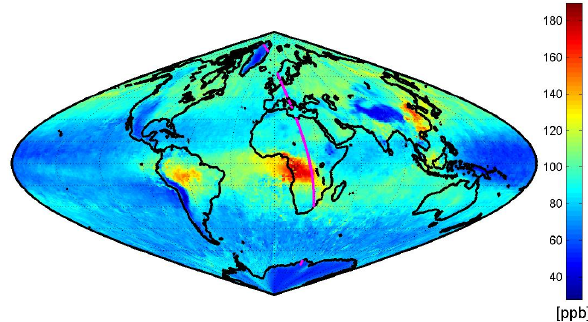
Fig. 6. Global background X CO distribution based on MOPITT data (Deeter et al., 2003, 2007a, b). The magenta line shows the projec- tion of the land portion of just one of the orbits used in the simula-